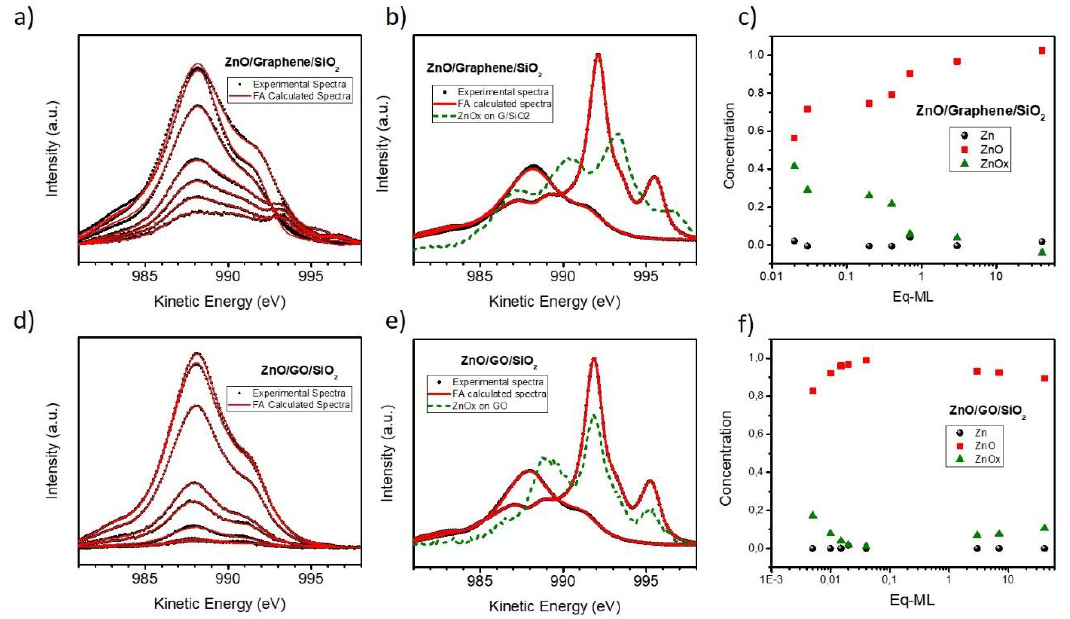
Figure 8. Results of factor analysis applied to the Zn-LMM XPS spectra for the growth of ZnO on G / SiO 2 ( a – c ) and GO ( d – f ). ( a ) and ( d ): Calculated and suggested bases used in factor analysis. ( b ) and ( e ): Fittings of the experimental spectra using a linear combination of the proposed components. ( c ) and ( f ): Concentration for each of the components as a function of the coverage.